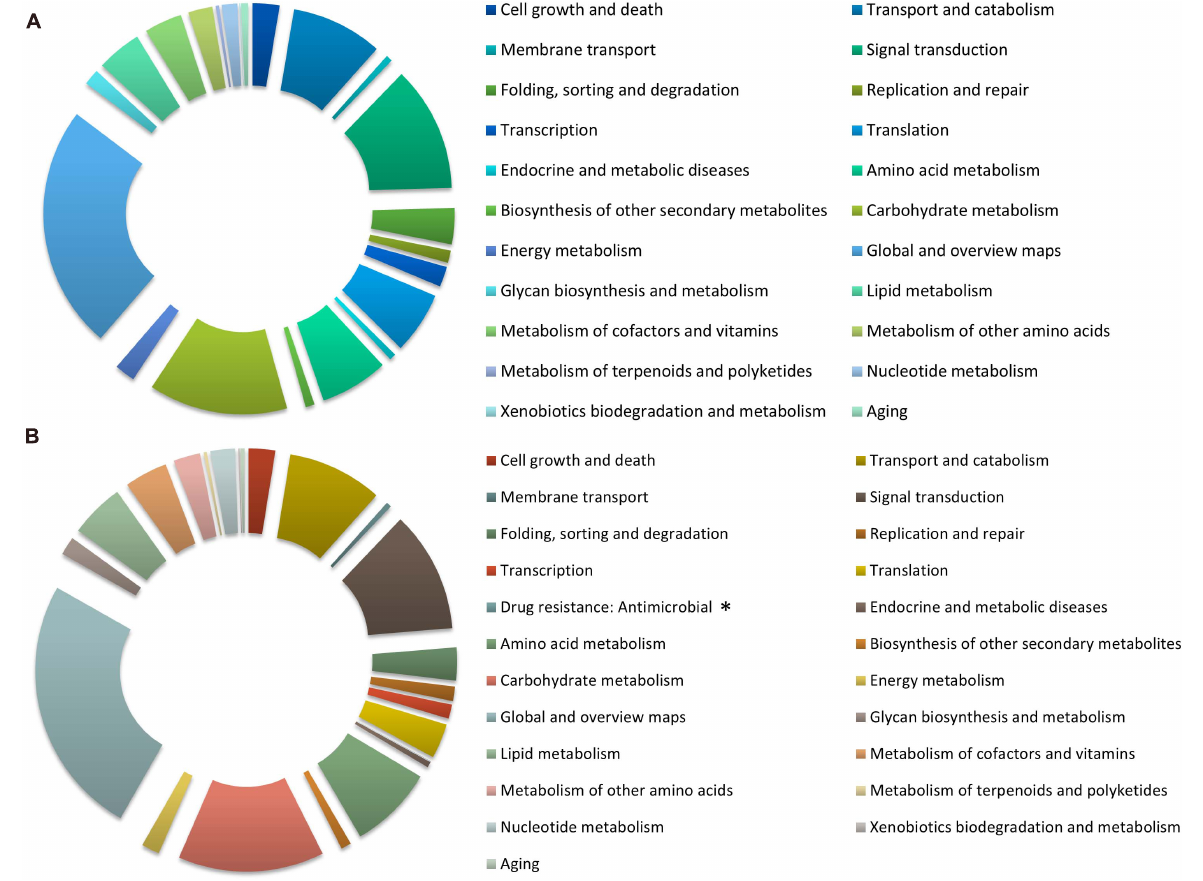
FIGURE 4 | The Kyoto Encyclopedia of Genes and Genomes (KEGG) classification of DEGs under different nitrogen treatments in Verticillium dahliae. The pie charts exhibit KEGG classification of genes differentially expressed in V. dahliae strain XS11 in response to various nitrogen sources, including 10 mM nitrate (NO 3 − )